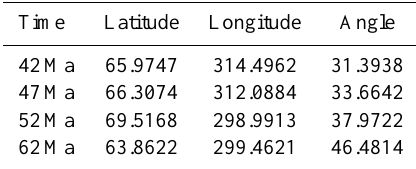
Table 3. Finite poles of rotation for the geodynamic model. Time